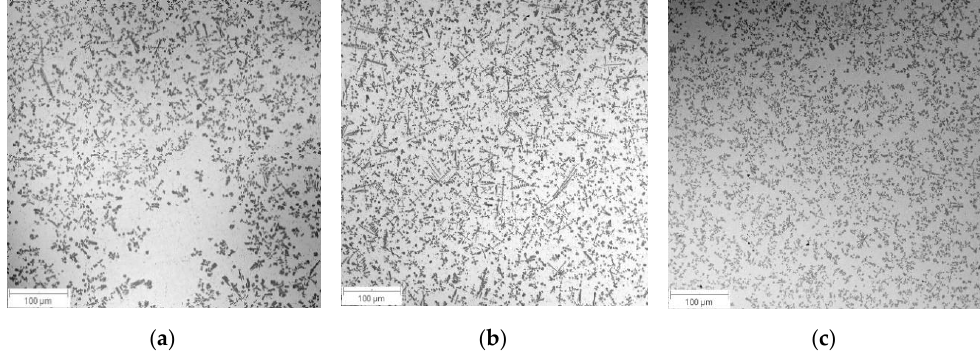
Figure 3. Low-magnification BSE SEM micrographs taken at the mid-section of SAB no. ( a ) T2, ( b ) TC3, ( c ) TM3 (Table 2).